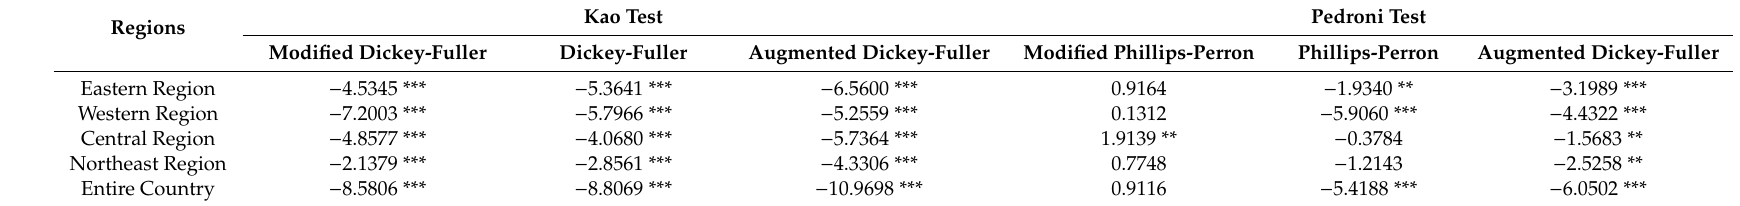
Table A2. Co − integration test results.